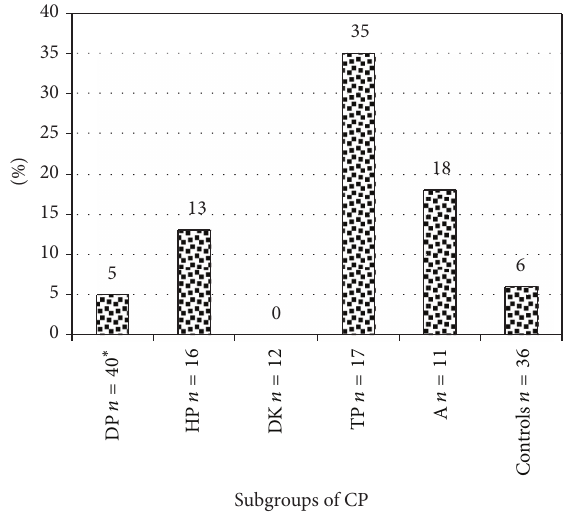
Figure 2: Percentage of patients testing positive for IgA/IgG antibodies to TG6 in different CP subgroups and in a control group. The tetraplegic subgroup compared to the other CP subgroups ( 𝑃 = 0.006 ) and to controls ( 𝑃 = 0.01 ); ∗ 𝑛 = 3 missing for TG6